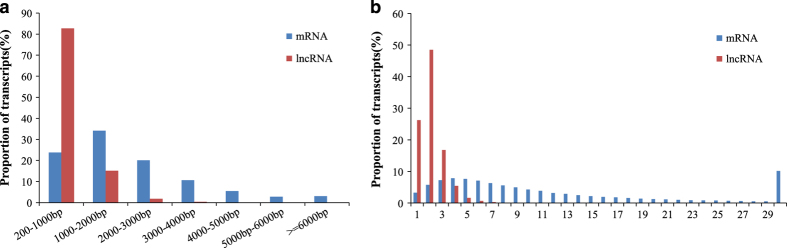
Identification of lncRNAs and mRNAs in C. carpio gonad.(a) Length of lncRNAs and mRNAs. (b) Exonic content of lncRNAs and mRNAs.